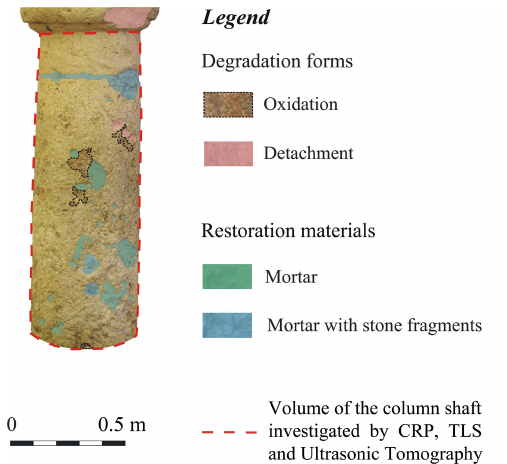
Figure 4. Shallow macroscopic characteristics of the investigated